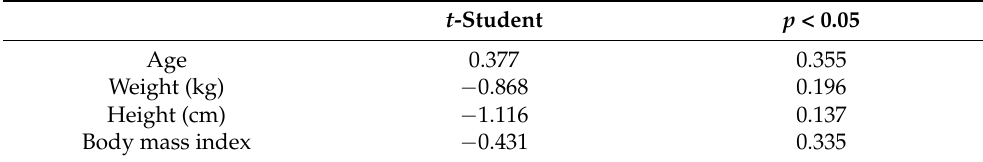
Table 2. Student’s t -test for independent samples on the control variables.